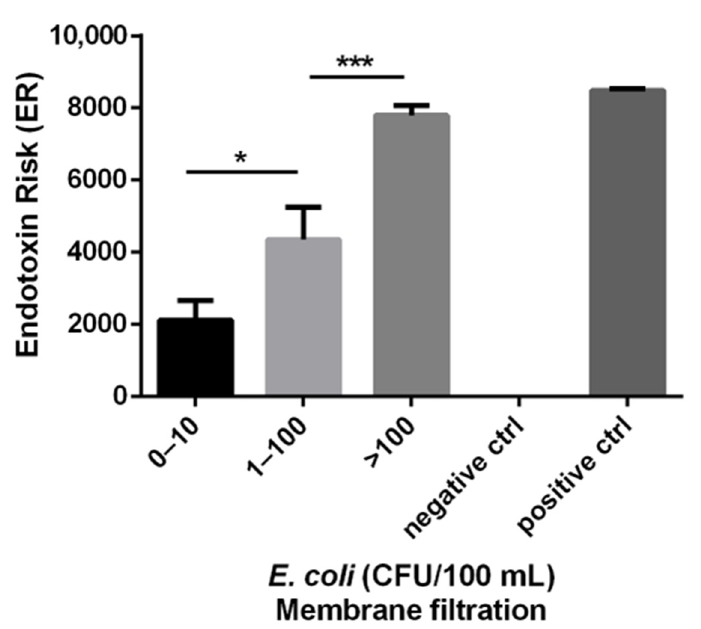
Figure 1. A Pearson correlation between the endotoxin units (EU/mL) and ER. Endotoxin unites were calculated using the Kinetic-QCL™ assay and compared to ER as calculated using BacterisK. n = 64, p < 0.0001, R 2 = 0.929.